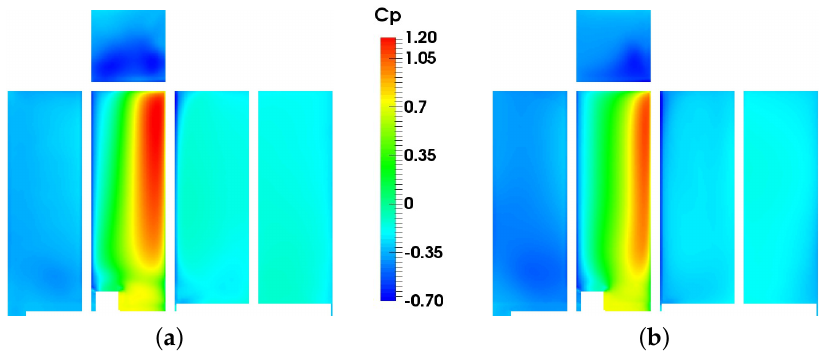
Figure 20. Pressure coefficients obtained on the building faces for ( a ) the reference sample ( α = 1, θ = 0) and ( b ) the c-APK average over the 57 samples. The building faces are presented here, from left to right, in the order east, north, west and south, with the top face on top of the